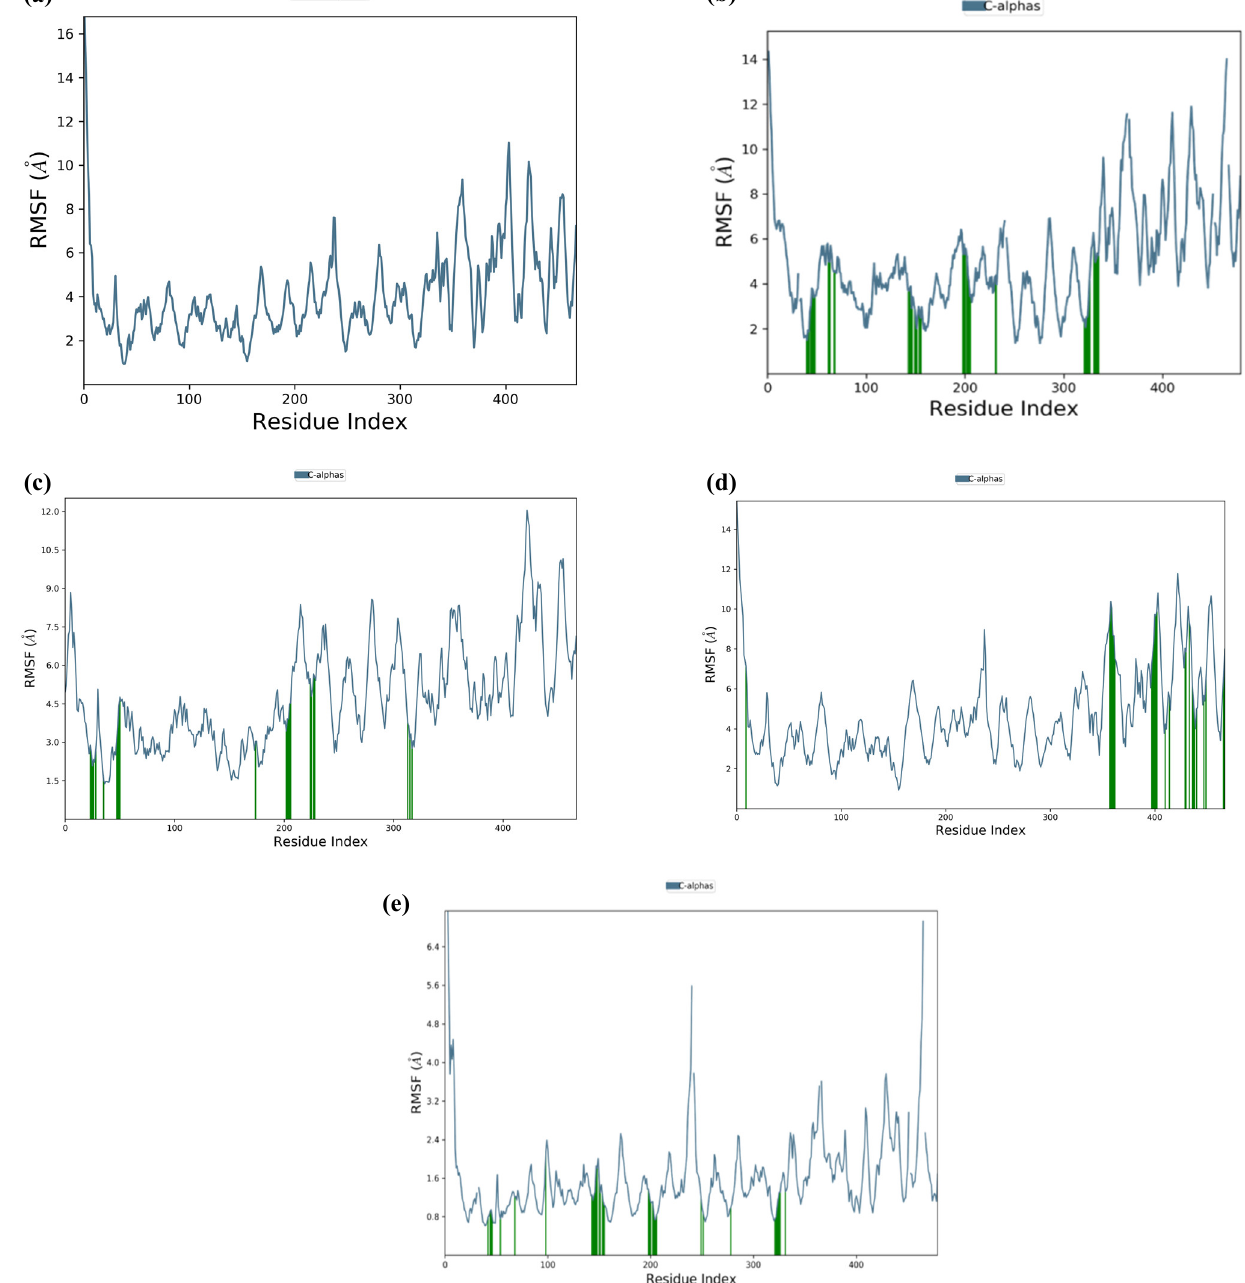
Figure 5. Residue wise Root Mean Square Fluctuation (RMSF) of protein–ligand complexes during 150 ns. ( a ) capsid protein with GSTR peptide; ( b ) capsid protein with TDGH peptide; ( c ) capsid protein with LEEV peptide; ( d ) capsid protein with WDDG peptide; ( e ) capsid protein with EGDE peptide. The RMSF of docked protein showed no fluctuation of interacting residues, where green vertical lines are representing interacting residues.